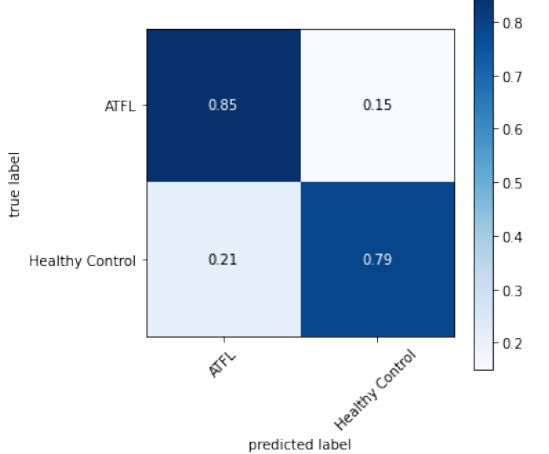
Figure 8. Confusion matrix obtained for the RF classifier with Set 5 chosen for